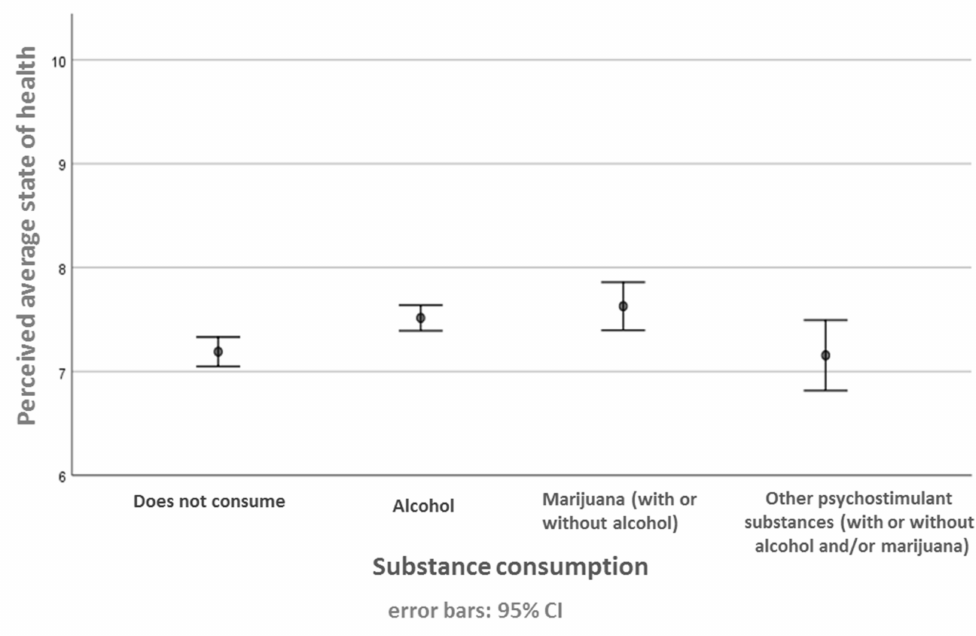
Figure 2. Perceived health status as a function of substance use. Perceived state of health was evaluated on a scale of 0–10. The data are expressed at mean ± standard deviation for each substance